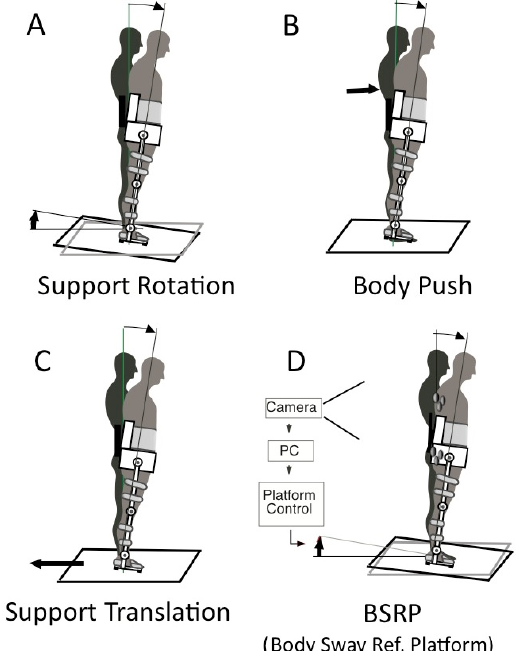
Figure 6. ( A – D ) Suggested four basic tests of self-balancing of the exoskeleton (resorting directly to testing of human postural control and its application in humanoid robots; compare